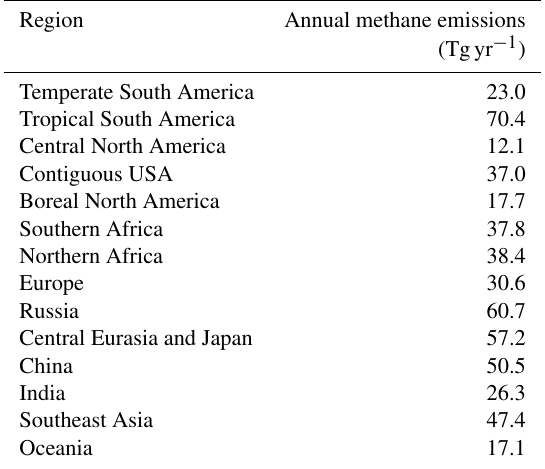
Table 3. Regional annual methane emissions from